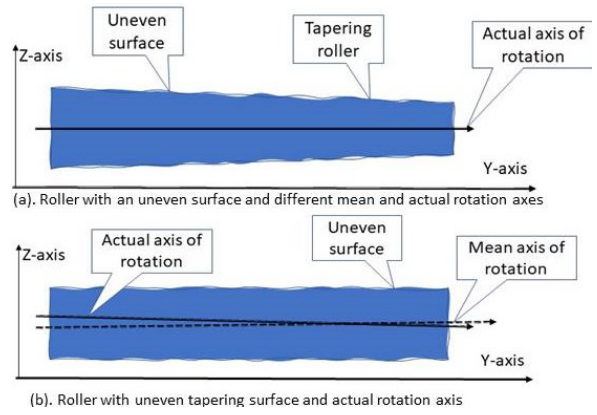
Figure 3. Cross-sectional view of rollers showing surface erosion, mean and tilted rotational axes.